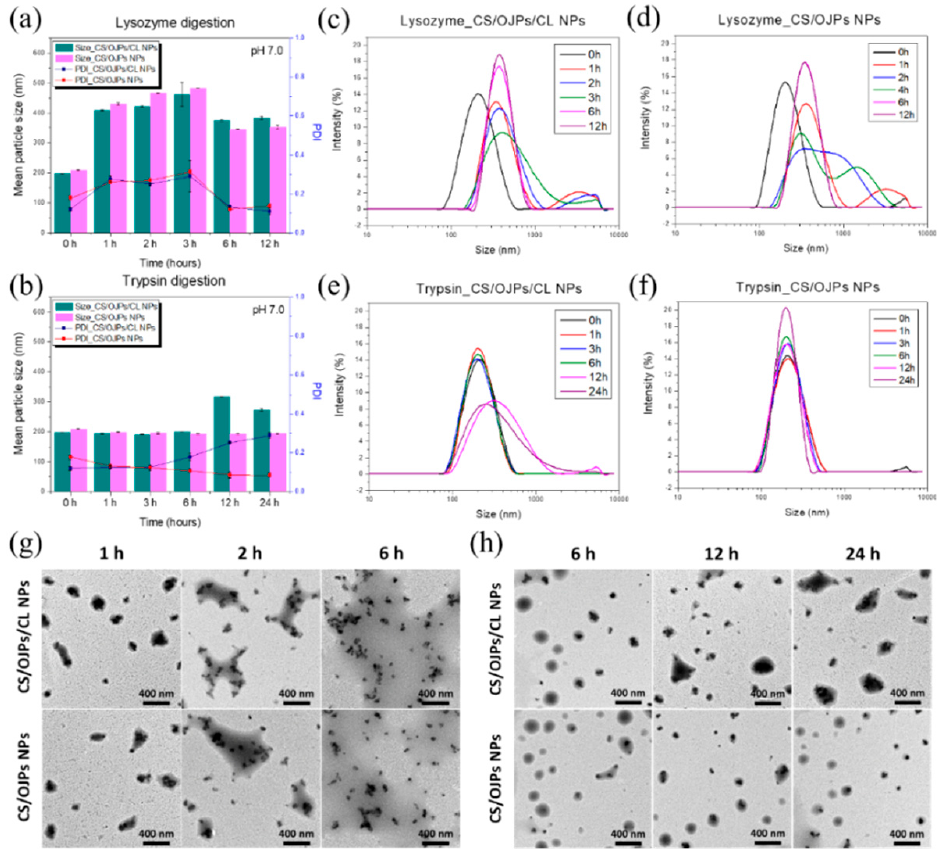
Figure 4. ( a , b ) Mean particle size and PDI of CS/OJPs and CS/OJPs/CL NPs degraded by lysozyme (1.0 mg/mL) and trypsin (0.5 mg/mL). ( c , d ) Size distribution curves of CS/OJPs and CS/OJPs/CL NPs degraded by lysozyme (1.0 mg/mL). ( e , f ) Size distribution curves of CS/OJPs and CS/OJPs/CL NPs degraded by trypsin (0.5 mg/mL). ( g , h ) TEM micrographs of CS/OJPs and CS/OJPs/CL